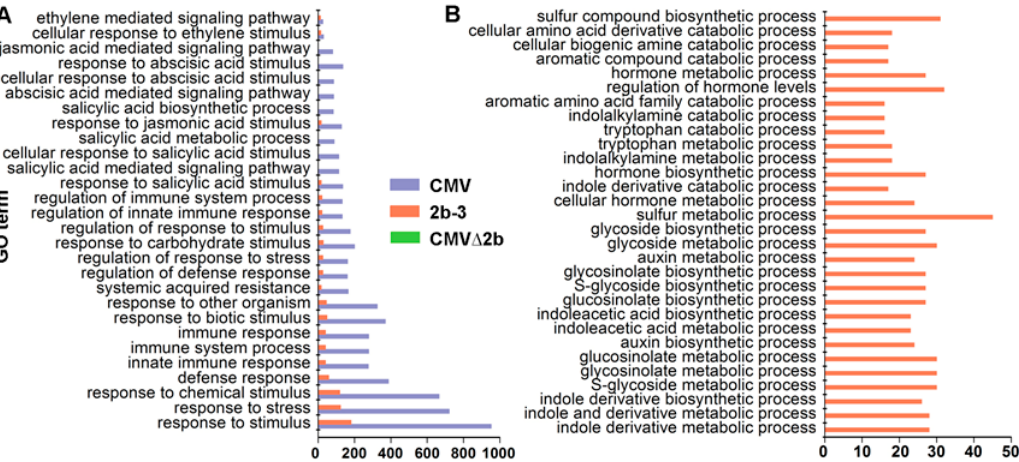
Figure 4. The specific enriched GO terms of genes induced in CMV-plants ( A ) and 2b-3 plants ( B ). Neither specific in plant immunity pathways nor metabolism pathways were found in CMV ∆ 2b-plants.